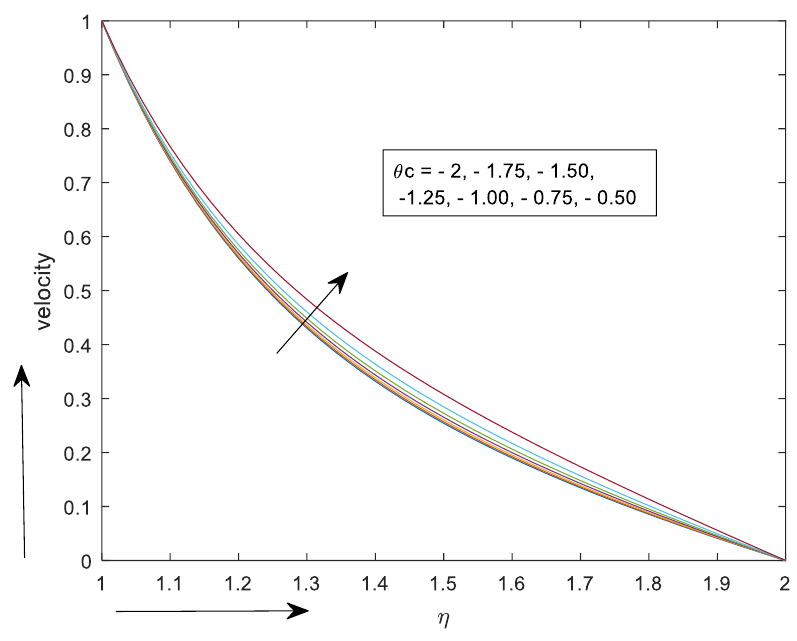
Figure 4. Velocity profile for different values of 𝜃